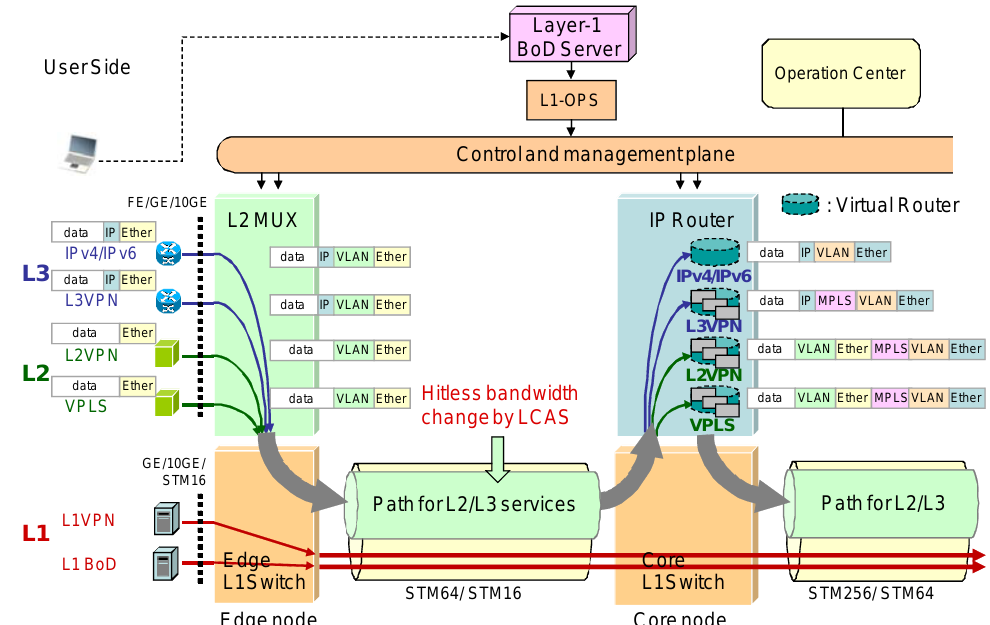
Figure 2. Network elements and networking